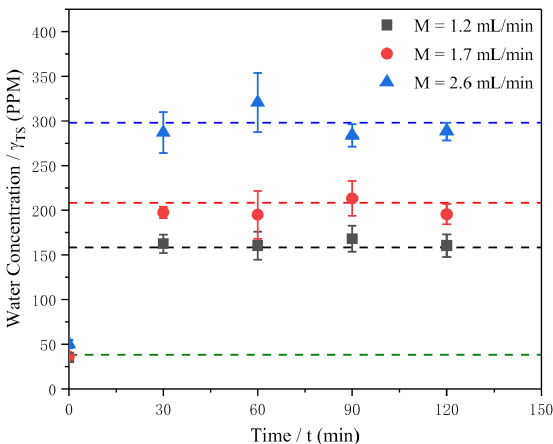
Figure 11. Comparison of theoretical and measured water concentration in the fuel samples. The spot lines represented the theoretical values.